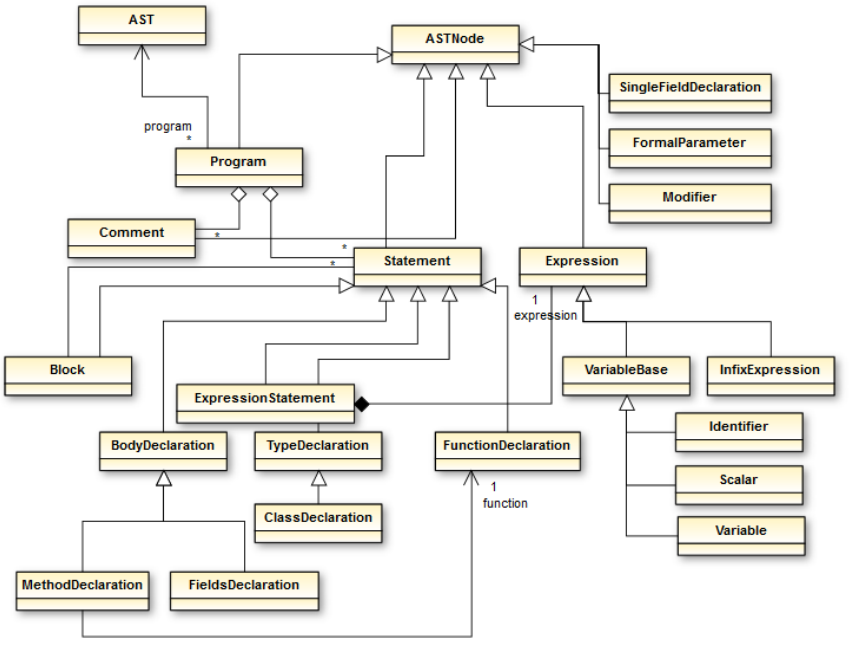
Fig. 4. SASTM for PHP language Table 1. Overview of the PHP SASTM